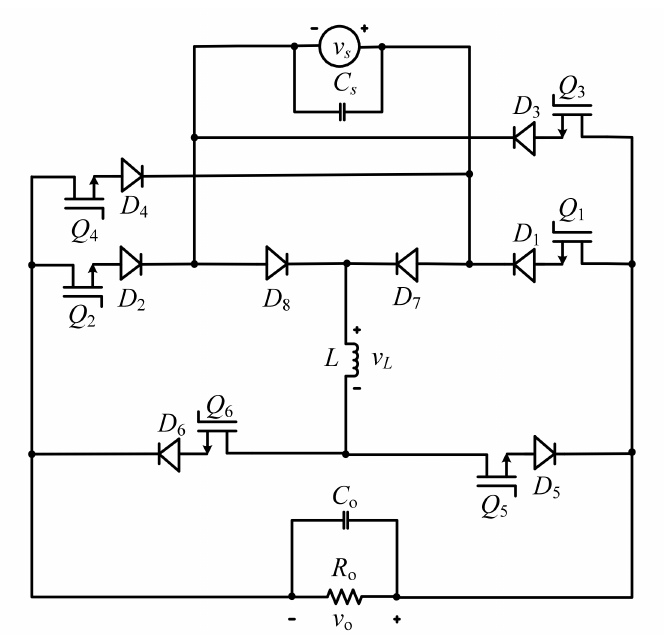
Figure 5. AC voltage controller reported in